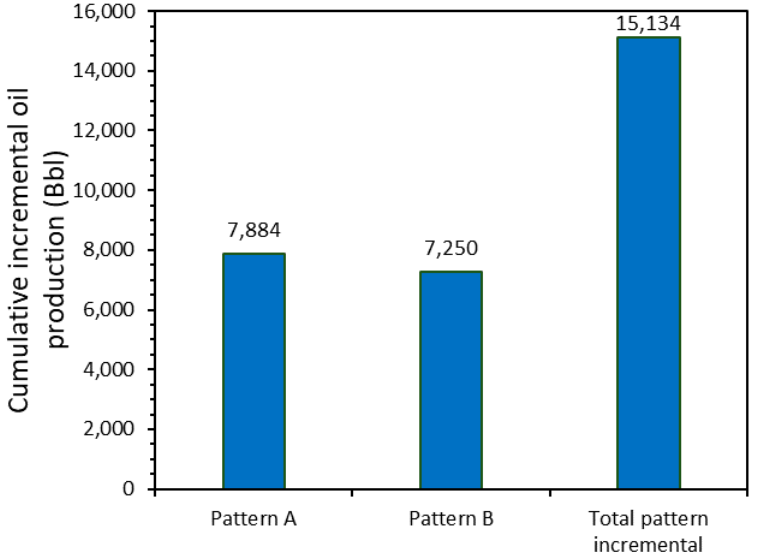
Figure 18. Cumulative incremental oil production obtained during the field tests for the patterns A and B and the total